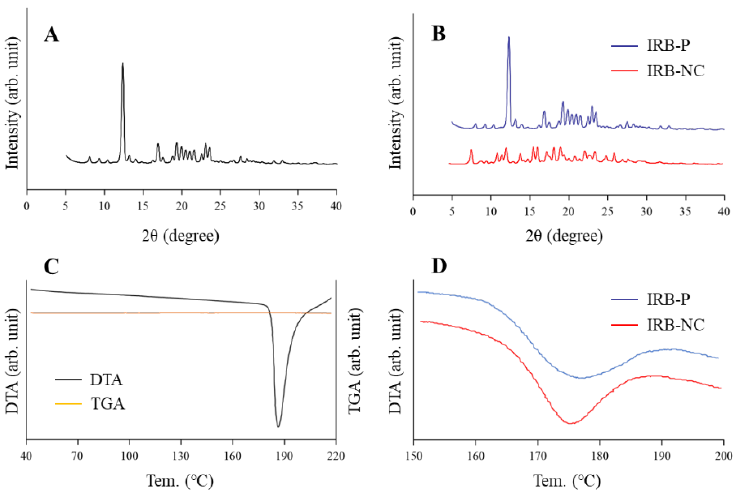
Figure 2. Analysis of the crystalline structure in irbesartan treated with or without a bead mill. ( A )